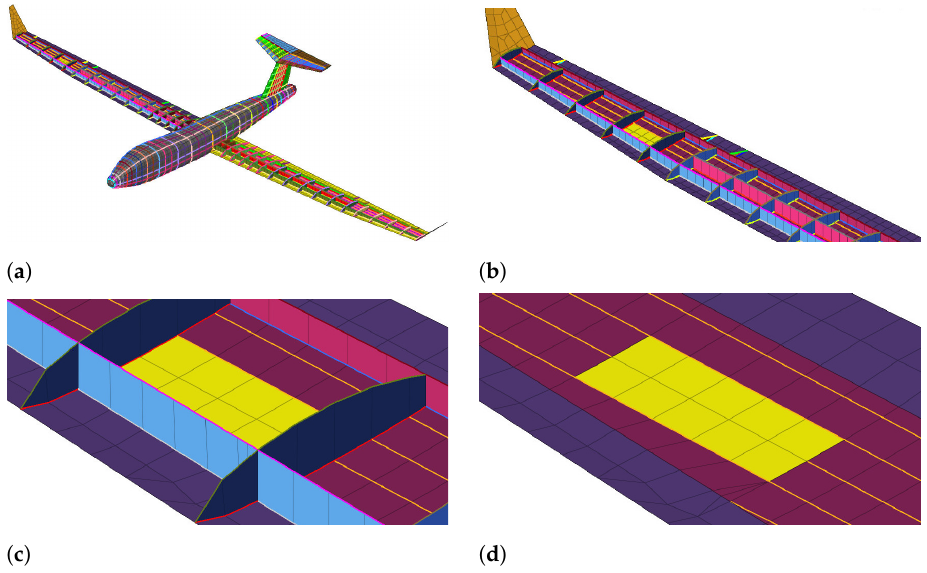
Figure 21. Non-regular area (in yellow) as represented in the aircraft model. ( a ) OptiMALE with the wing upper-skin removed; ( b ) Zoom on the right wing (upper-skin removed); ( c ) Zoom on the non-regular area (in yellow); ( d ) Zoom on the non-regular area with surrounding spars and ribs